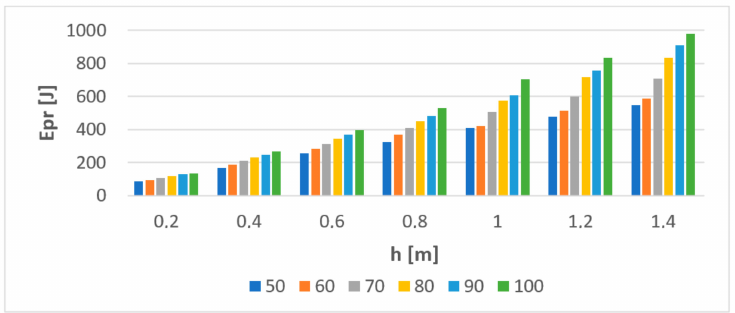
Figure 7. Impact energy E Pr of the hammer as a function of the impact height h, with the pyramidal impactor (for various masses in